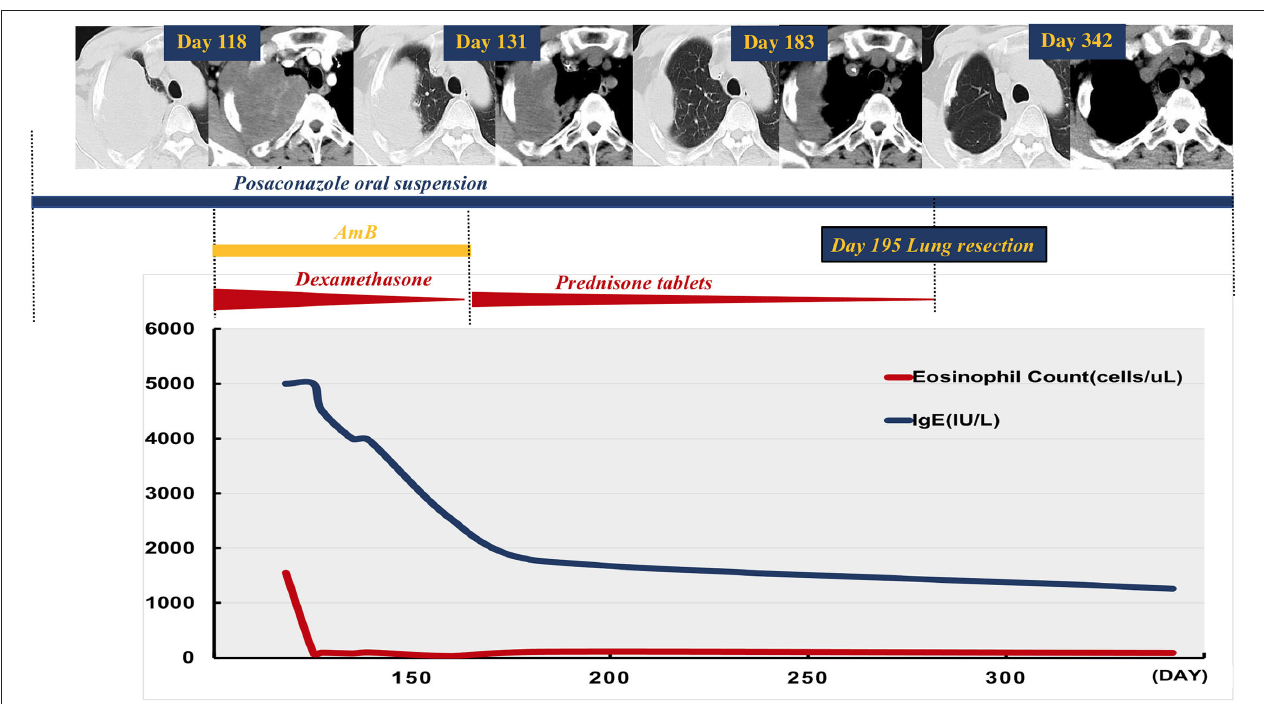
FIGURE 1 | Case time line. Chest computed tomography on day 118 depicted a mass in the right upper lobe of the lung involving the right chest wall, and there was no reduction in its size after 3 months of treatment with oral posaconazole suspension. Concurrent amphotericin B and dexamethasone were started after repeat diagnostic lung biopsy on day 120. Amphotericin B was stopped on day 128. Systemic corticosteroid (SCS, prednisone tablets) was given after repeat imaging on day 131 and depicted a marked reduction in mass size. Radiology on day 183 indicated substantial improvement in the lung lesions with concurrent weaning of